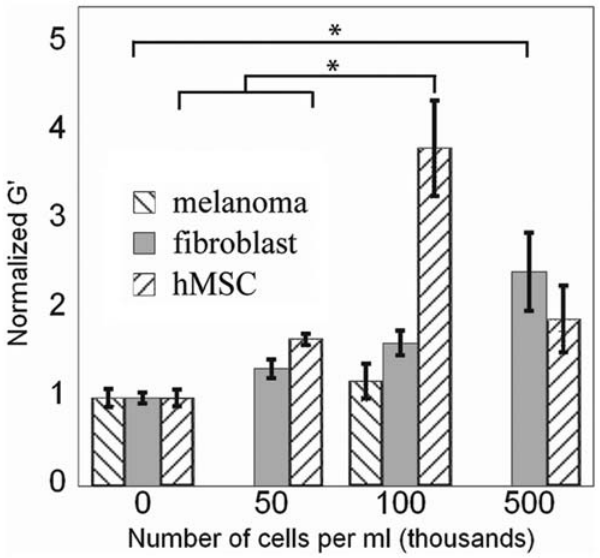
Figure 5. Embedded contractile cells stiffen the shear modulus of a 3D gel. Elastic shear modulus measured by rheology of fibrin gels cultured for 18 hours with varying densities of cells. Reported as mean 6 SE, n=3, 8 measurements per sample, *: p ,